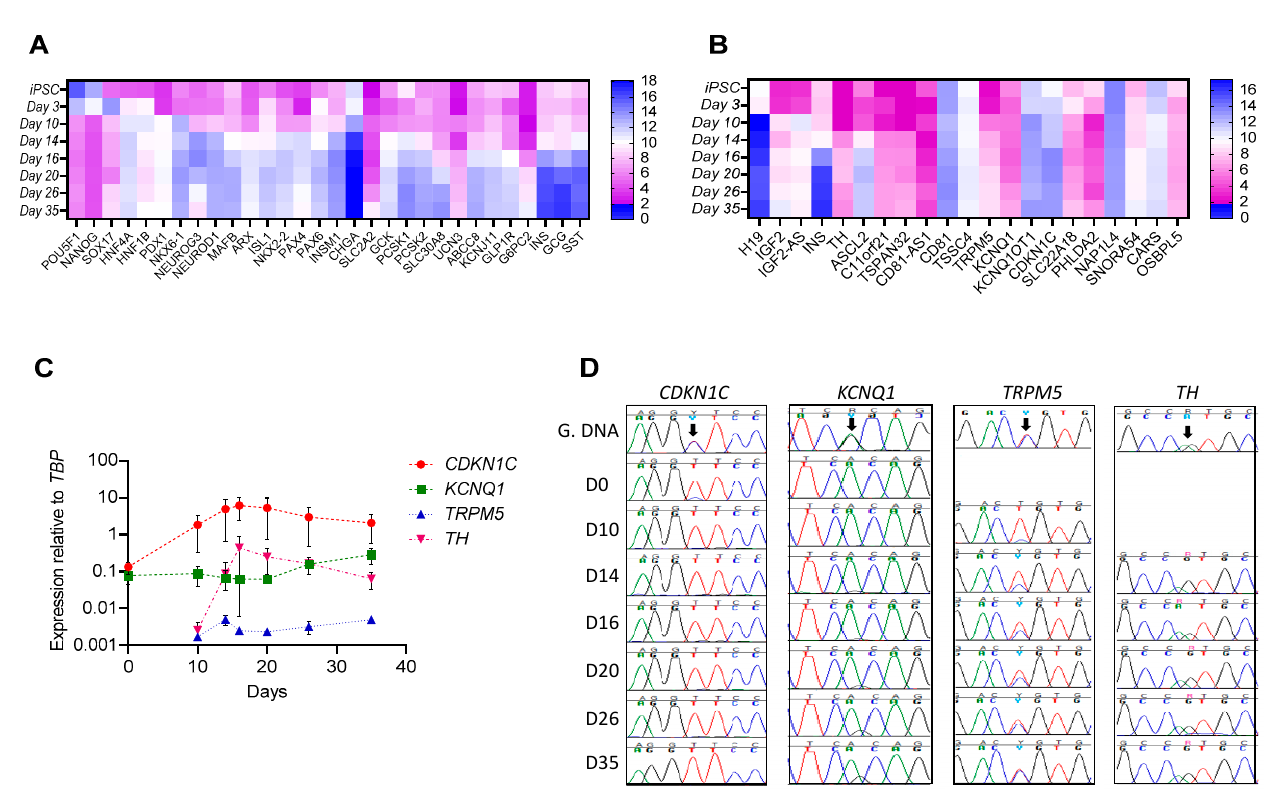
Figure 1. Gene expression and imprinting at the KCNQ1 locus during beta-like cell development from hiPSCs. ( A , B ). Heatmap showing average deseq2 normalized counts from RNA sequencing of different stages of beta-like cell differentiation from three different American Indian hiPSCs for ( A ) selected stage specific differentiation markers and ( B ) genes in a 1.1 mb region at the KCNQ1 locus. ( C ). Expression of KCNQ1 , CDKN1C , TRPM5 and TH during different stages of beta-like cell differentiation relative to the expression of TBP (housekeeping gene) from the same stage ( n = 2). ( D ). Chromatograms showing a heterozygous coding SNP (arrow) in KCNQ1 , CDKN1C , TRPM5 and TH in genomic DNA (G.DNA) from hiPSCs and either monoallelic or biallelic expression (as seen by either one peak or two peak) in cDNA from different stages of differentiation. D0—iPSCs, D10—Pancreatic progenitors, D14 and D16—Endocrine progenitors, D20—immature beta-like cells, D26 and D35—mature beta-like cells.